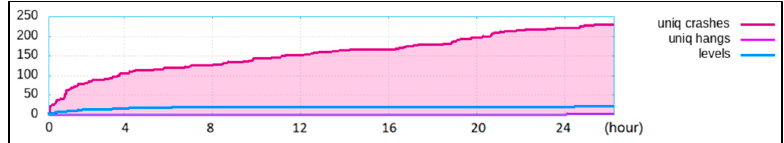
Figure 7. Experimental record of fuzzing readelf.